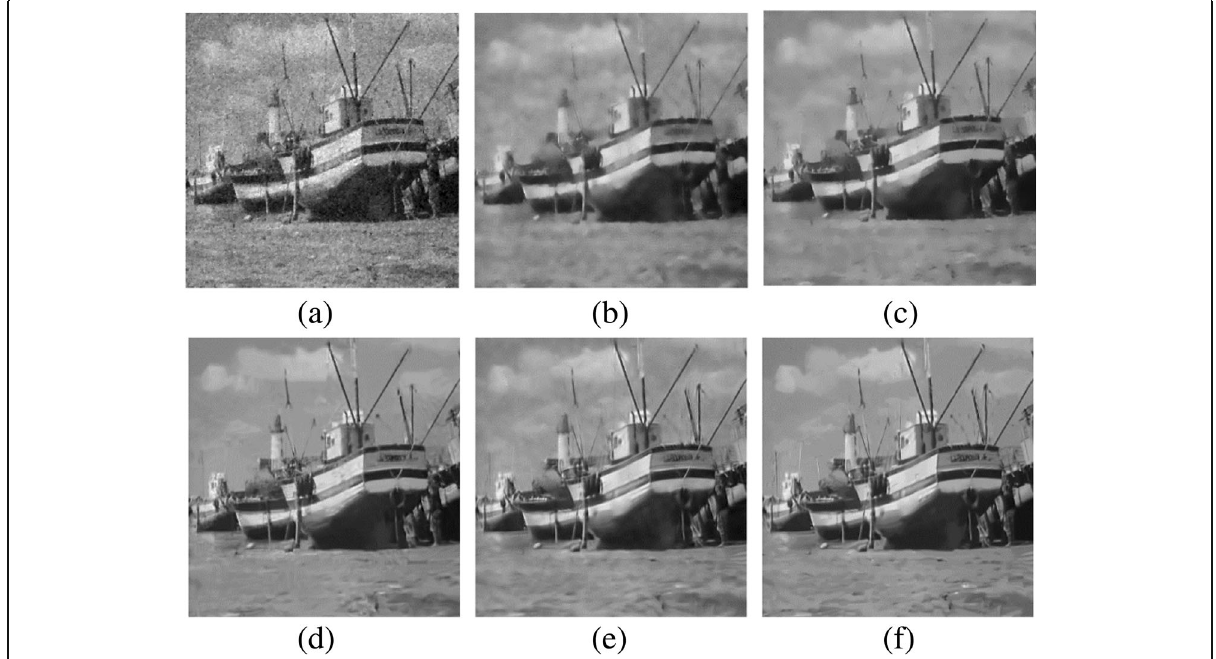
Fig. 3 Visual comparisons of denoising results on Boat image corrupted by additive white Gaussian noise with standard deviation 50: a TV-based regularization [28] (PSNR = 22.95 dB; SSIM = 0.456); b NLM [38] (PSNR = 24.63 dB; SSIM = 0.589); c R-NL [56] (PSNR = 25.42 dB; SSIM = 0.647); d NCSR model [66] (PSNR = 26.48 dB; SSIM = 0.689); e LRA_SVD [78] (PSNR = 26.65 dB; SSIM = 0.684); f WNNM [58] (PSNR = 26.97 dB; SSIM = 0.708)